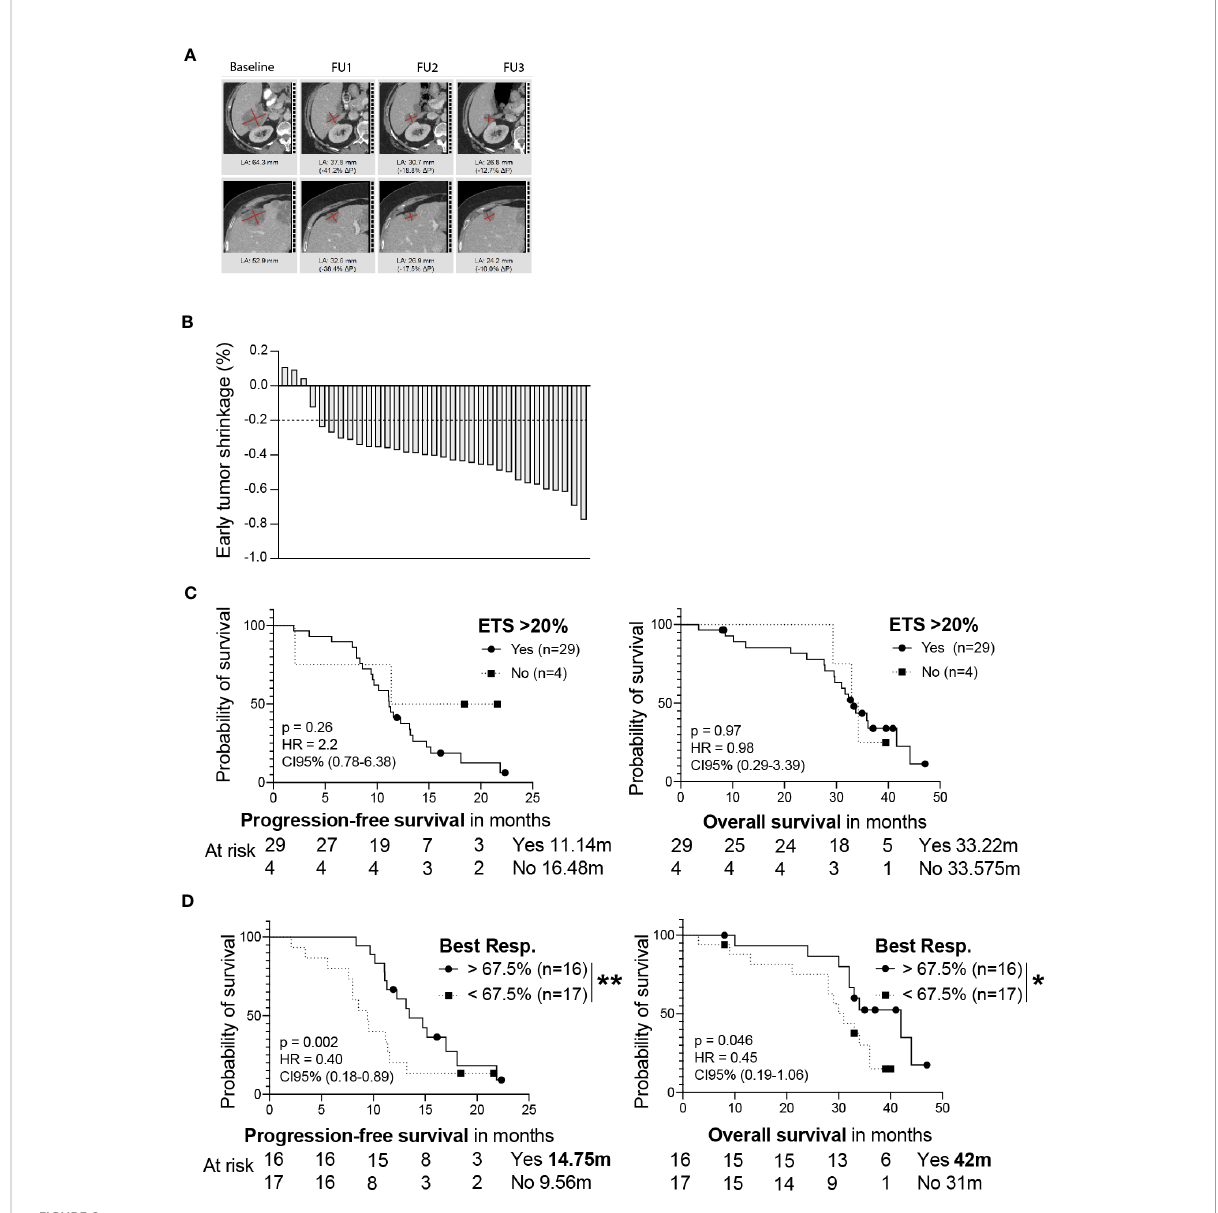
FIGURE 2 (A) Central radiological review of CTs from patient 49002-011 are depicted as an example. Target lesions are shown at baseline and FU examination 1 to 3. (B) Percentage of the patient ’ s early tumor shrinkage was calculated as the difference of the fi rst follow-up CT scan relative to the baseline CT scan. A 20% cut off is depicted. PFS (left) and OS (right) is shown for patients either experiencing or not ETS of at least 20% (C) . PFS (left) or OS (right) for patients experiencing a depth of response greater than 67.5% tumor shrinkage or patients experiencing a worse response is shown (D) . Median survival of each group and patients at risk are depicted. Statistical signi fi cance was calculated using a log-rank Mantel-cox test, * indicates a p value of < 0.05, ** indicates a p value